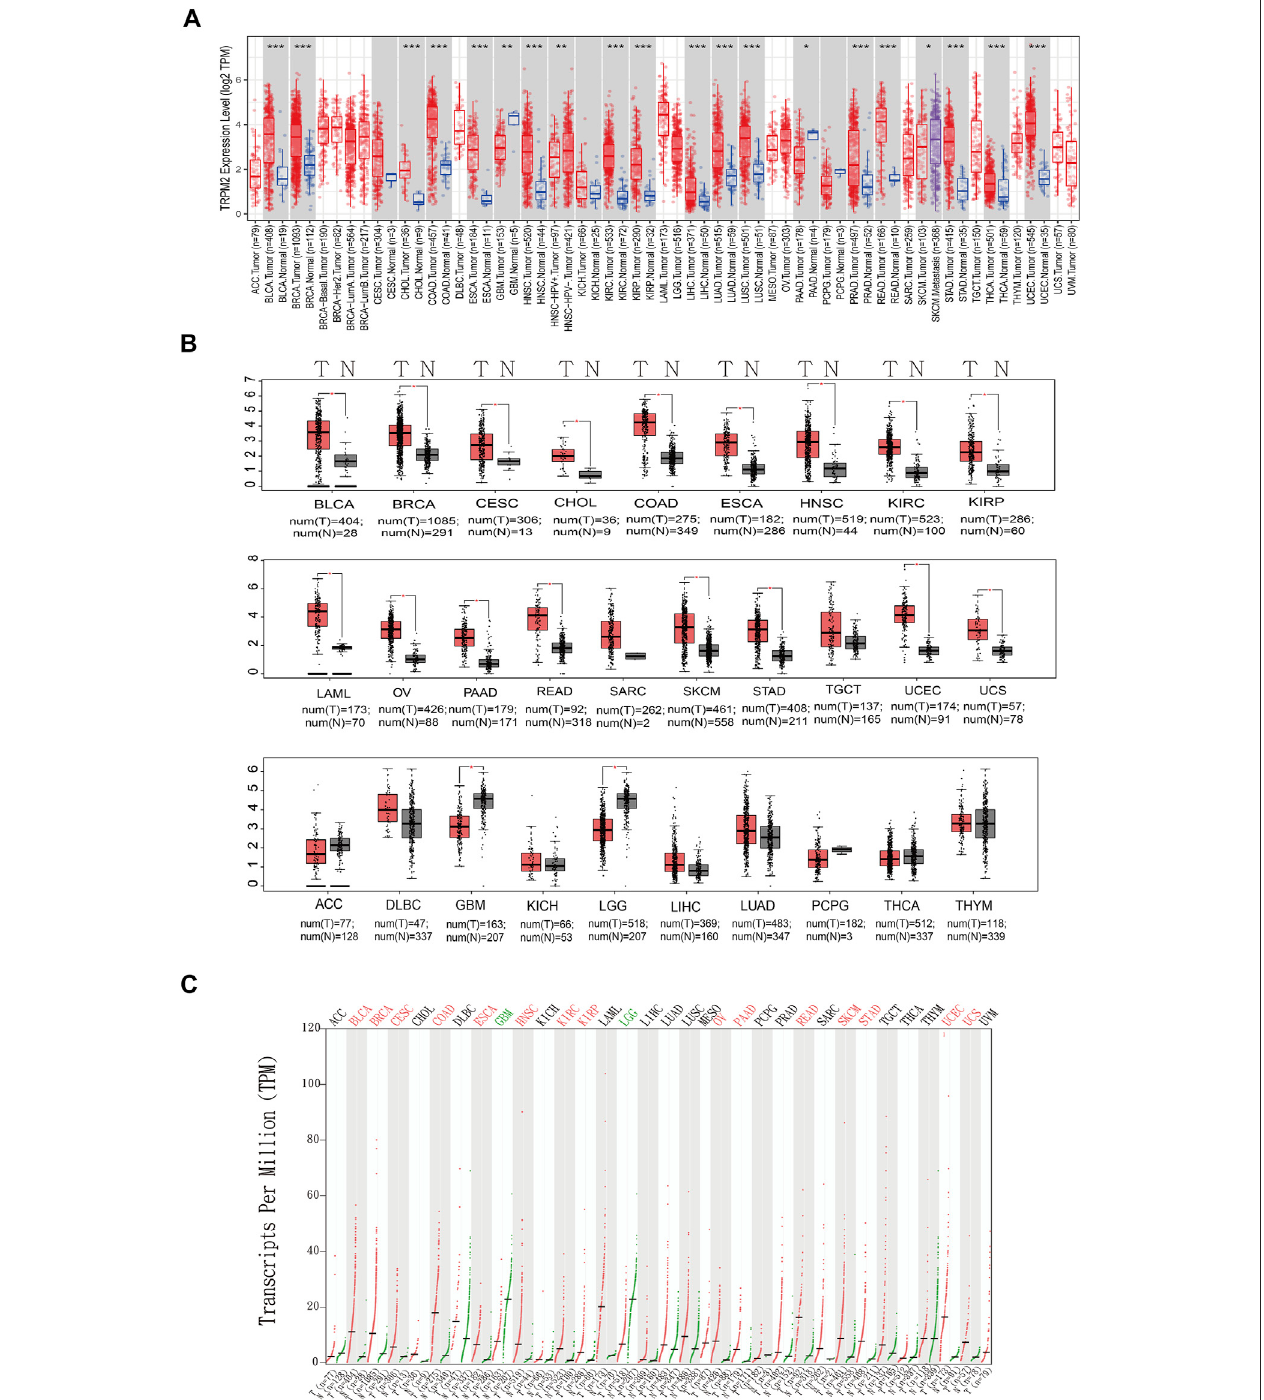
FIGURE 1 | Expression of TRPM2 in different cancers. (A) Box plot showing the expression level ofTRPM2 in different cancer types compared to adjacent normal tissues determined based on data from The Cancer Genome Atlas (TCGA) using TIMER 2.0. The signi fi cance computed by Wilcoxon ’ s test was annotated by the number of stars . (B) Box plots displaying the expression of TRPM2 in different cancers with a p -value cutoff of 0.01 and log2FC cutoff of 1 from the Gene Expression Pro fi lingand Interactive Analysis(GEPIA) database. (C) Dot plotshowing theexpression pro fi le ofTRPM2acrossmultiple cancersand paired normaltissues.Each dot represents the expression of samples from the GEPIA database. * p < 0.05, ** p < 0.01, *** p < 0.001.